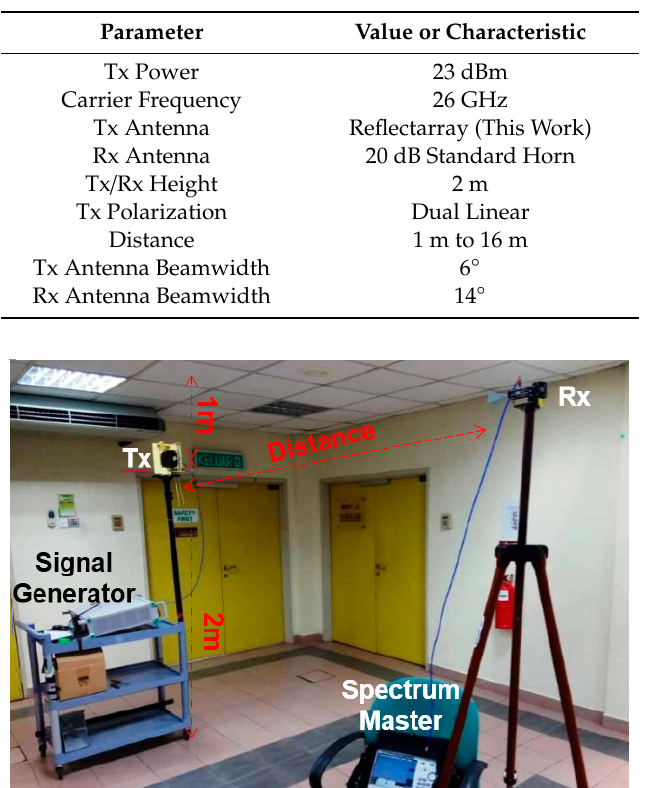
Table 2. Characteristics of RSS measurement setup.